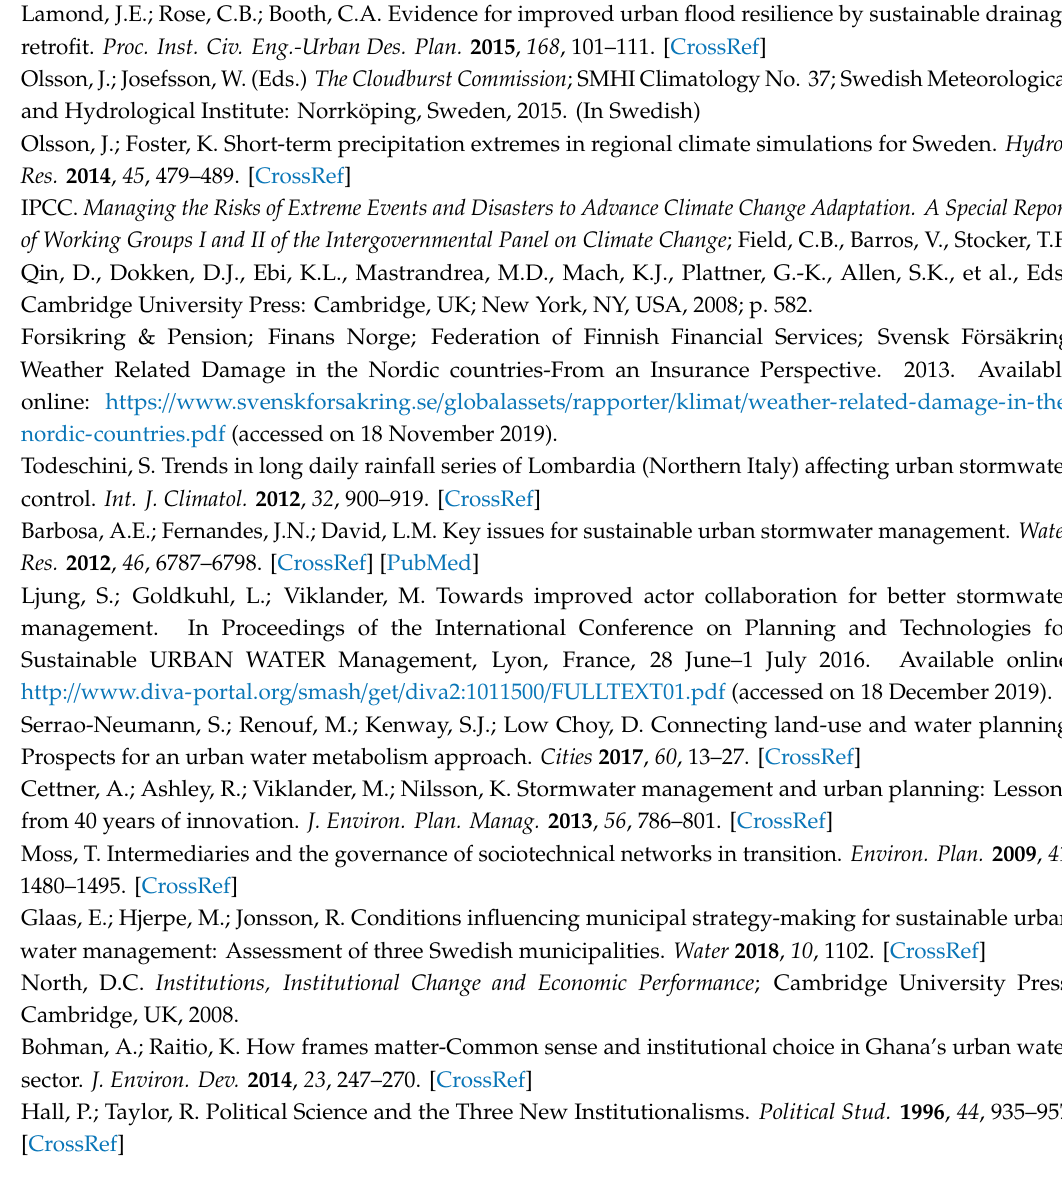
Table S1: Overview of perceived challenges for and needs to improve sustainable stormwater planning and management in Sweden, and proposed ways forward through institutional